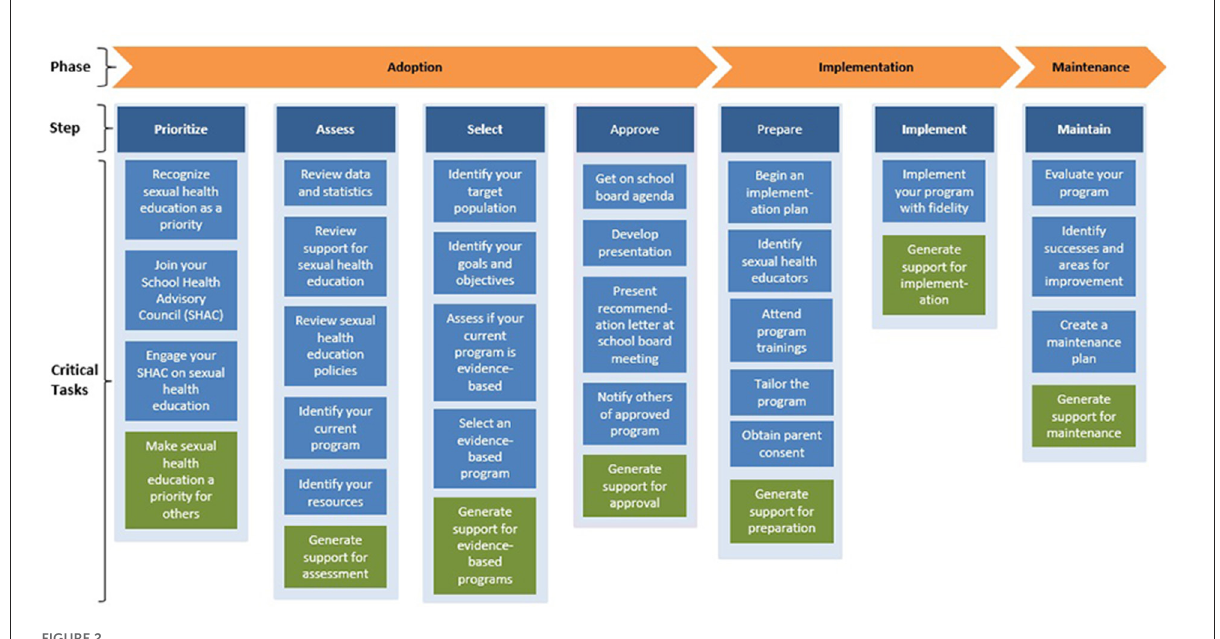
FIGURE2 Phases, steps, and critical tasks in the CHAMPSS model (19).